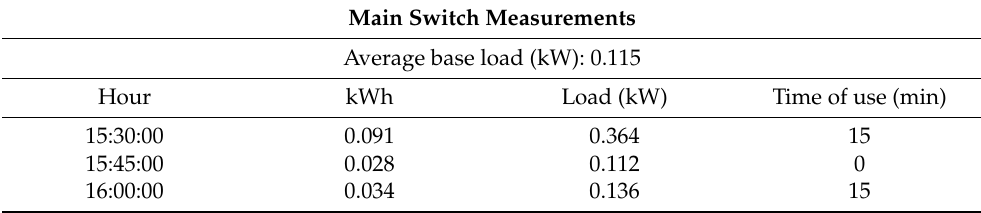
Table 3. Quantification of time of